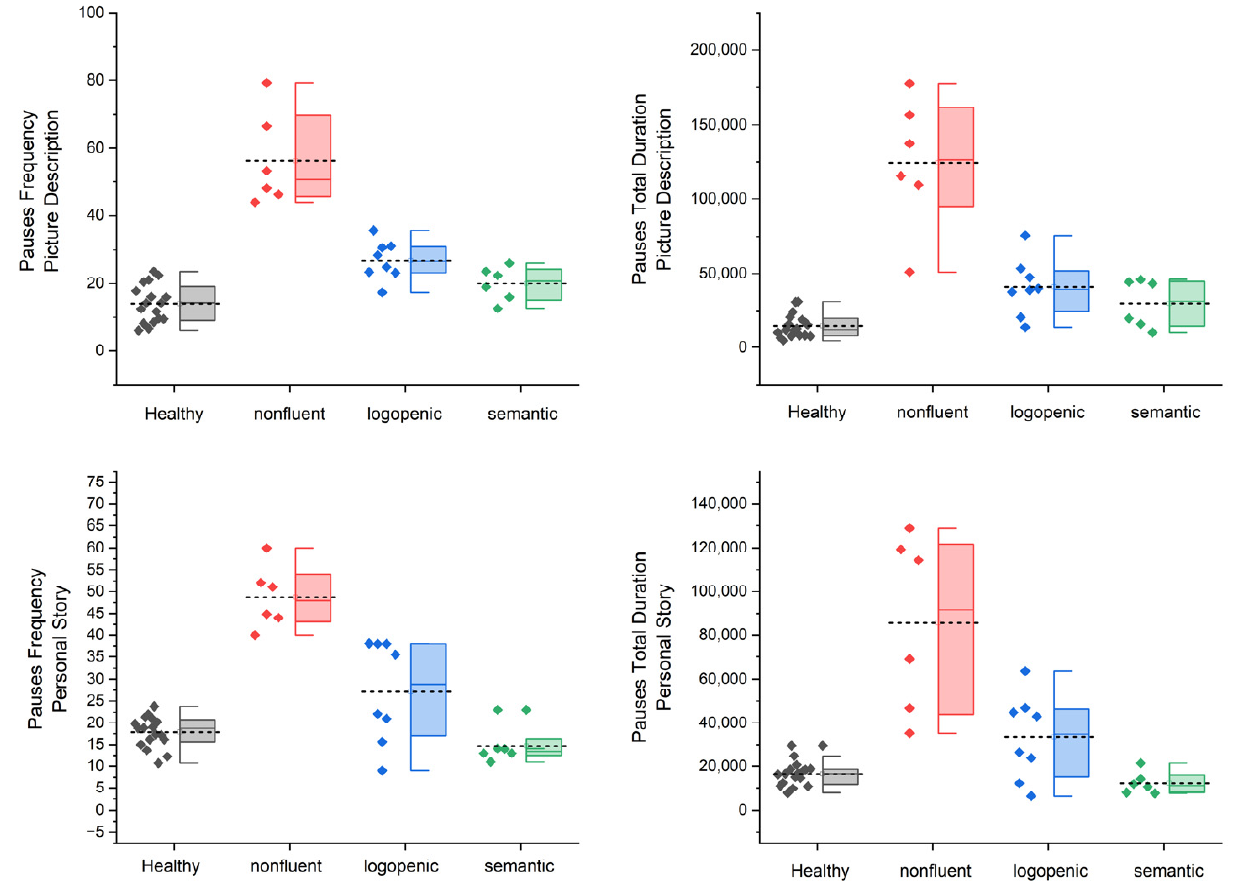
Figure 1. Box plots of pause total duration and frequency data for each type of diagnosis. First row: picture description task. Second row: personal story narration. Each box has a range of 25–75, the whiskers indicate the range of the outliers, the colored line inside each box is the median, and the short dashed lines are the mean.